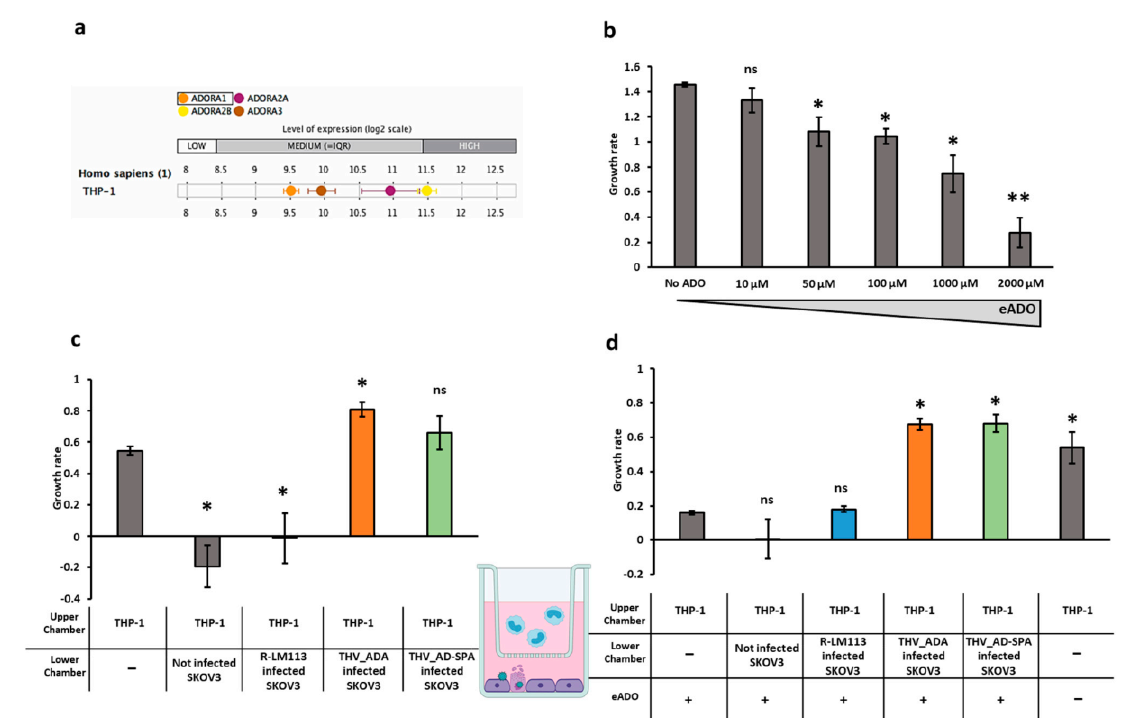
Figure 5. Effect of adenosine deaminase clearance on THP-1 monocytes proliferation. ( a ) RNA expression of ADO receptors was investigated in THP-1 cells by Genevestigator software. ( b ) THP-1 growth rate in medium supplemented with the indicated concentration of eADO. ( c ) Growth rate of THP-1 in SKOV3 co-culture in the presence of the indicated oncolytic virus (R-LM113, blue; THV_ADA, orange; THV_ADA-SP, green histogram). ( d ) THP-1 proliferation in THP-1/infected- SKOV3 co-culture assay in the presence of 2 mM ADO. Growth rates for ( b – d ) were calculated as log (2) of ratio between live THP-1 cells on day 2/day 1. Statistical significance for ( b – d ) were calculated in comparison to the first sample represented in the chart (No ADO; THP-1 mono-culture; THP-1 mono-culture with 2 mM ADO) and are reported as * for p -value < 0.05; ** for p -value < 0.005 and ns for not statistically